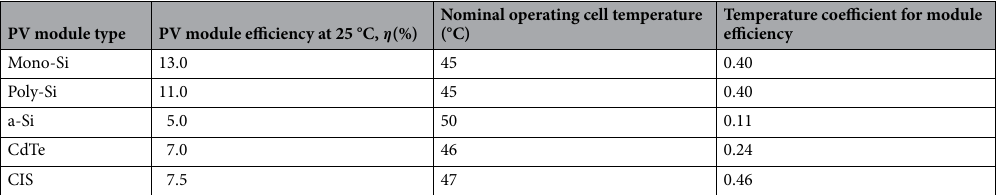
Table 1. The PV module features standard technologies 33